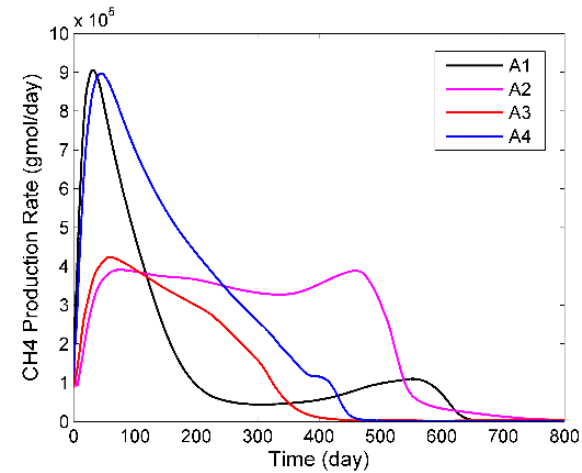
Figure 15. Adsorbed concentration of CO 2 after 30 days’ injection (unit: 1.0 × 10 − 3 m 3 /kg coal).